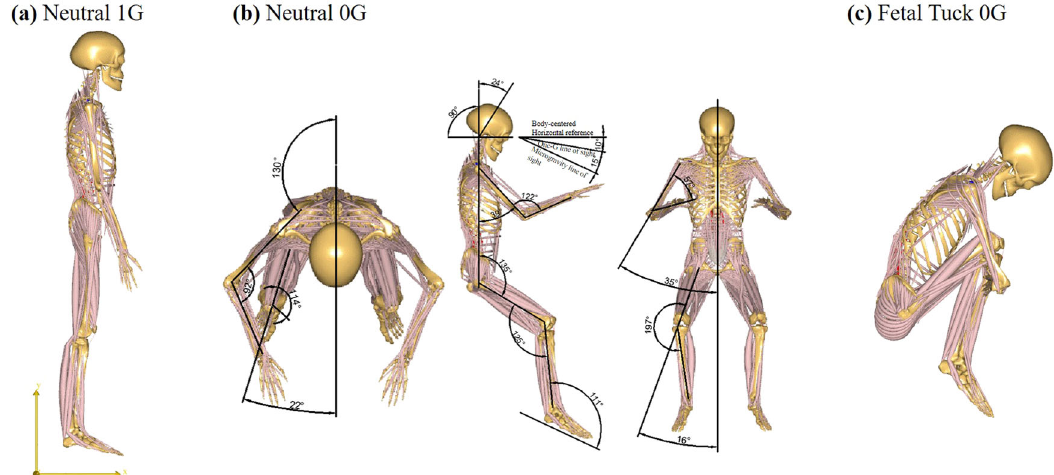
Fig. 1 The postures simulated in 1G gravity and microgravity. a Relaxed standing posture in 1G gravity (Neutral 1G); this posture was also used in microgravity for comparison (Standing 0G), b relaxed fl oating posture in microgravity (Neutral 0G), and c fetal tuck posture in microgravity (Fetal Tuck